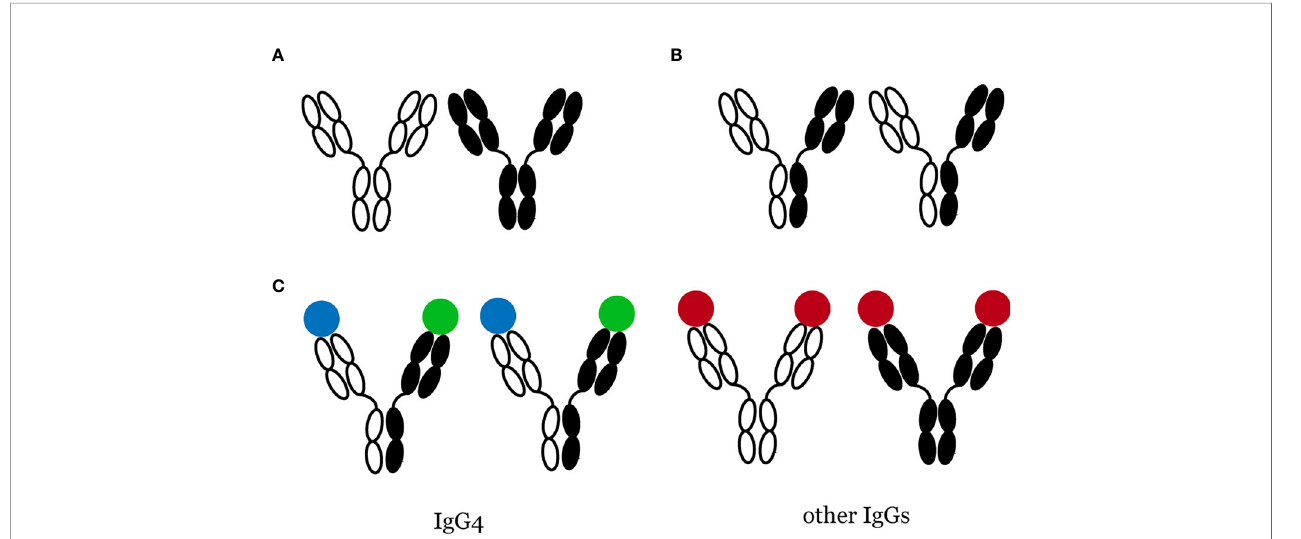
FIGURE 1 | Bispeci fi c IgG4 antibodies are produced through Fab-arm exchange. (A) Most IgGs do not change their structure, (B) Fab-arm exchange of IgG4 antibodies, (C) IgG4 is functional monovalency while other IgGs are